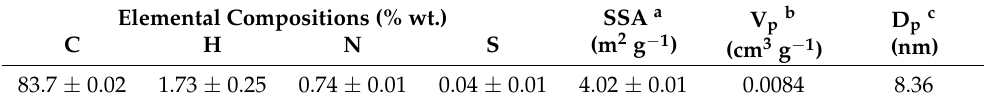
Table 3. Physiochemical characteristics of the eucalyptus wood-derived biochar. a BET specific surface area; b Total pore volume ( P / P 0 = 0.989); c average pore diameter (4 V / A by BET). Elemental Compositions (%